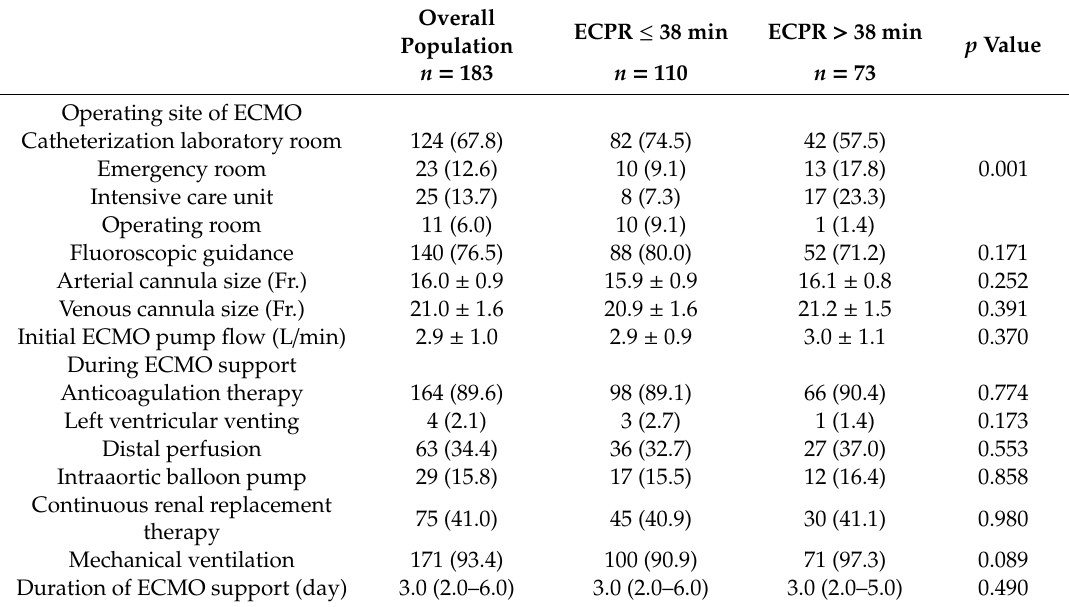
Table 2. ECMO and laboratory